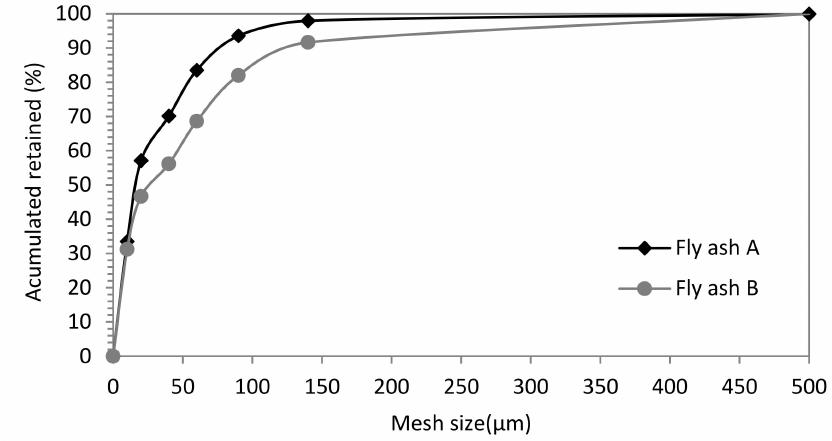
Figure 2. Particle size distribution of coal fly ashes A and